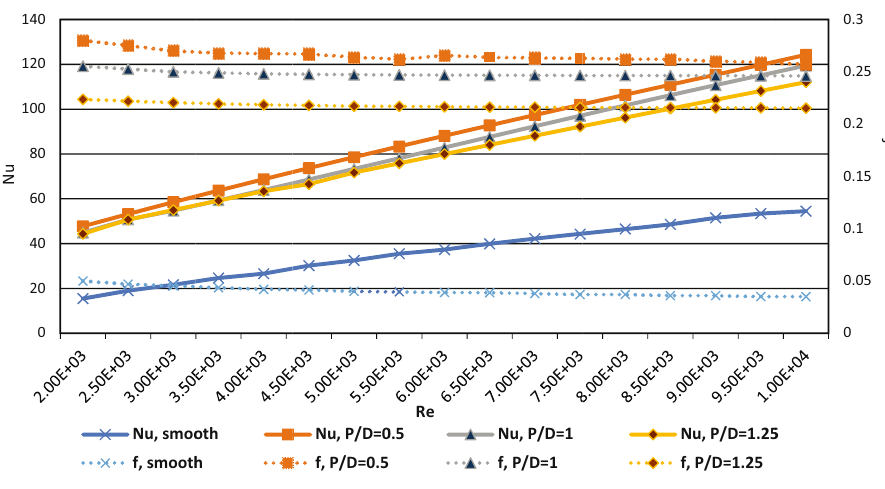
Figure 5: The e ff ect of ba ffl e pitch on Nusselt number and friction factor.